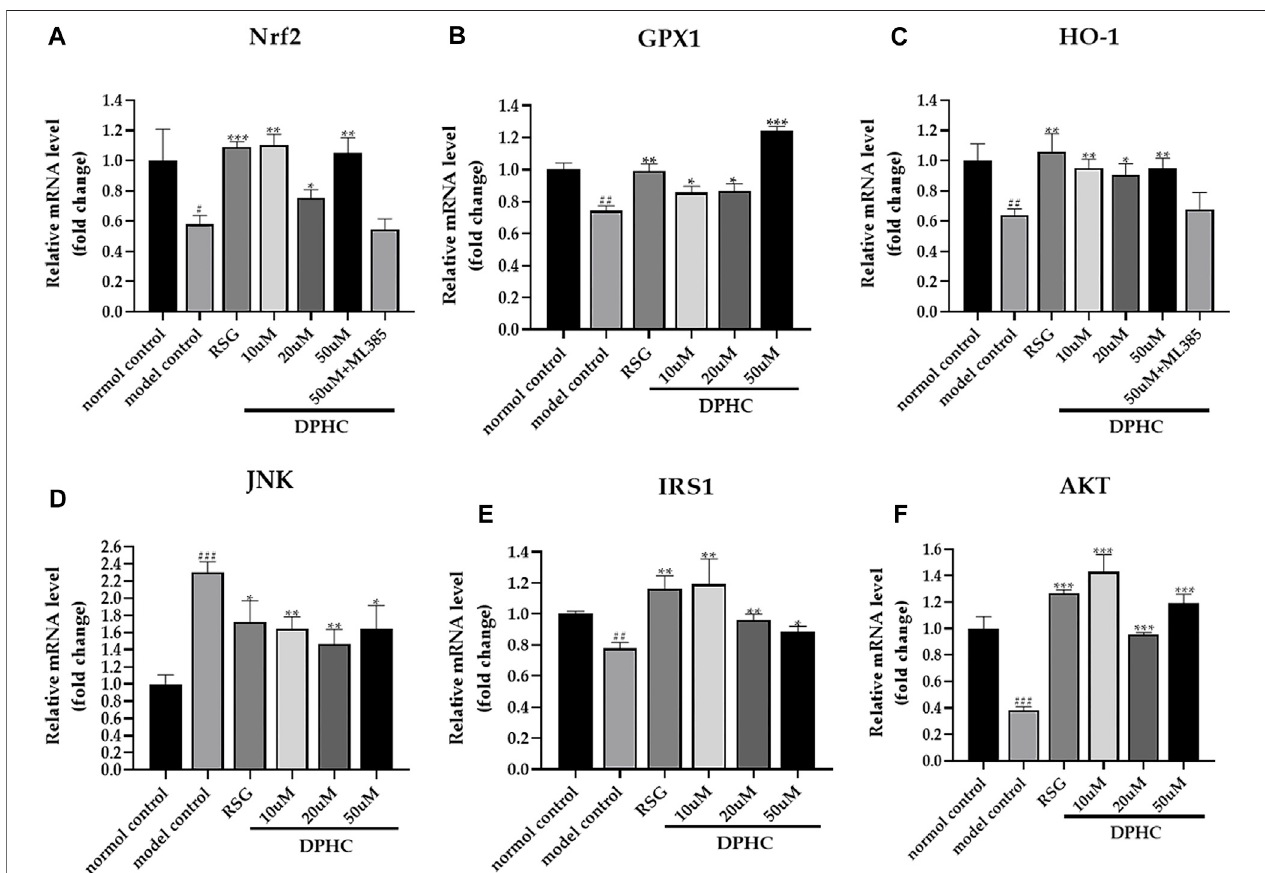
FIGURE 11 | Effects of DPHC on ameliorating oxidative stress and IR via Nrf2/ARE signal pathway-related mRNA in IR-HepG2 cells. (A) Nrf2 . (B) GPX . (C) HO-1 . (D) JNK . (E) IRS1 . (F) AKT .Theresultsofdifferentgroupswerenormalizedaccordingtotheresultsofthenormalcontrolgroup.Allvaluesareexpressedasmeans ± SD, n (cid:1) 3. * p < 0.05, ** p < 0.01, *** p < 0.001 compared with the model control group, and ## p < 0.01, ### p < 0.001 compared with the normal control